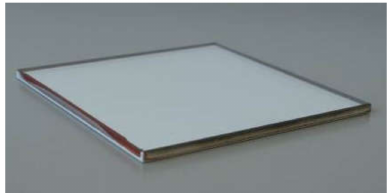
Figure 1. Mirror sample of second-surface silvered-glass reflectors before any